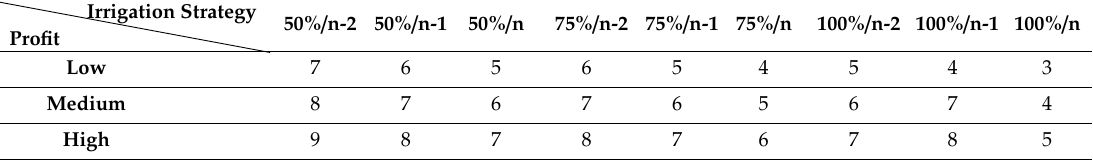
Table 7. Fuzzy Scorings.